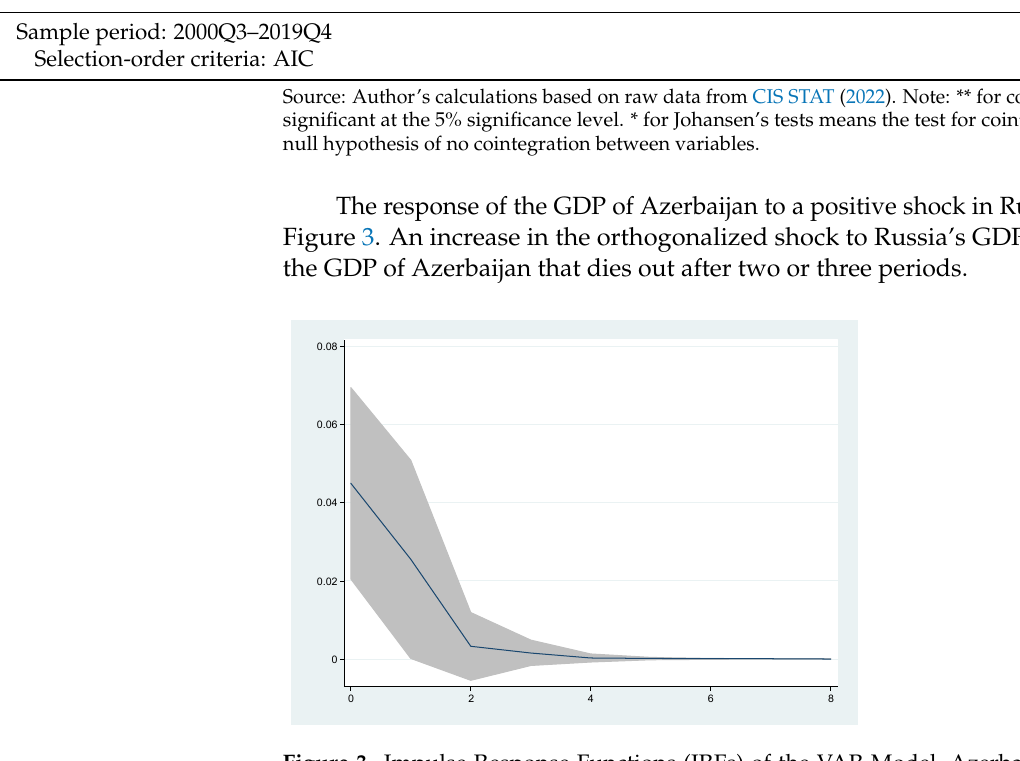
Figure 3. Impulse Response Functions (IRFs) of the VAR Model, Azerbaijan. Note: Response of Azerbaijan’s GDP to Russian GDP.